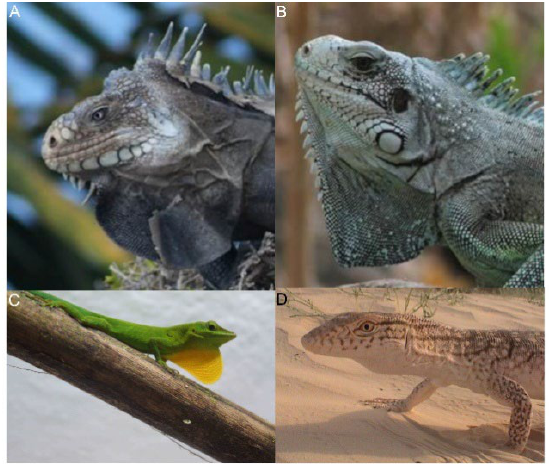
Figure 13. ( A – L ) Series of postures illustrating throat display movements (dewlap) in Anolis car- linensis . The time between each image is 0.01 s.